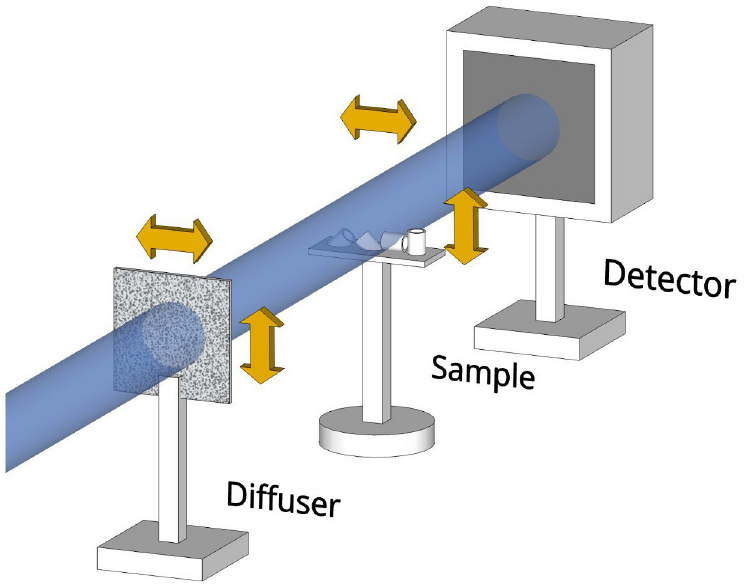
Fig 1. Schematic of a typical experimental setup used for SBI. The X-ray beam is patterned by the diffuser mounted on a scanning stage upstream of the sample stage. A detector system consisting of a pixel array detector scintillator- coupled to an optical microscope, giving sufficient resolving power to resolve the speckle pattern, is used to collect the images. Fig 2 visualises the image formation model. The sample transmission T at pixel r elled as a drop in the intensity, while refraction is modelled as the local displacement u of the speckle pattern, which is identical to the UMPA model used in our previous work [30]. In this